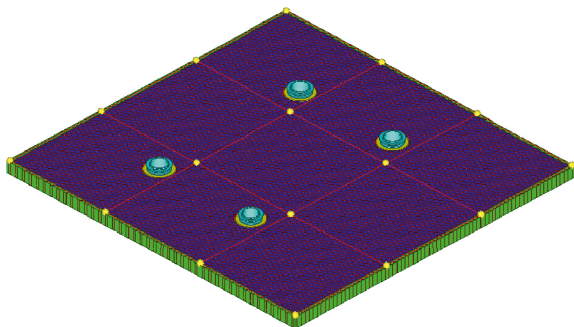
Figure 5: Sensor placement in the